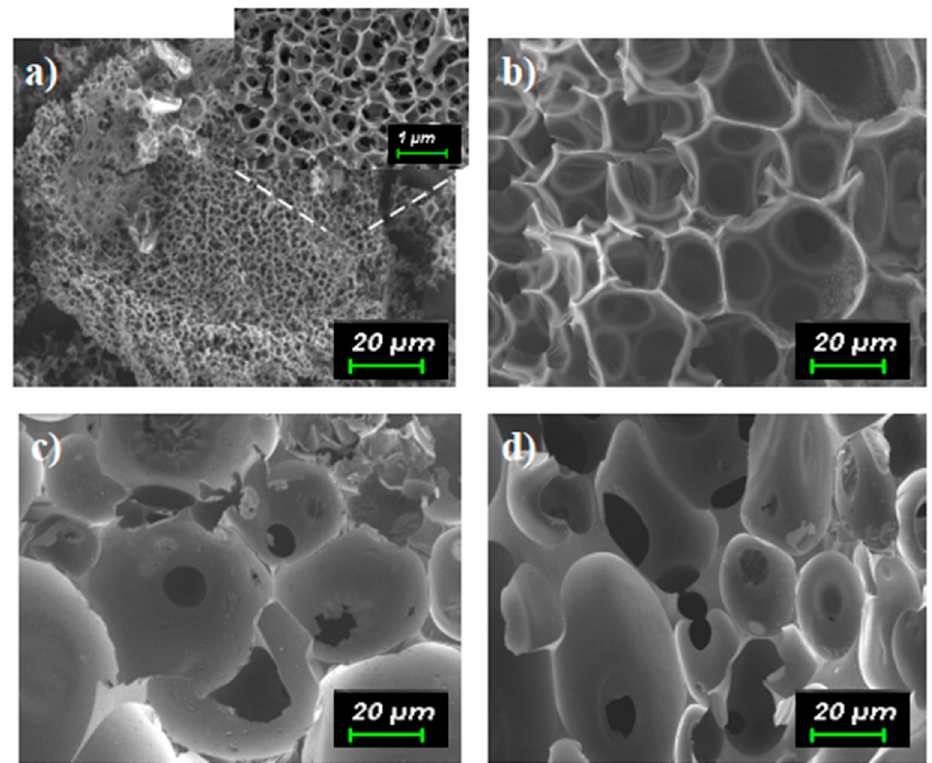
Figure 3. SEM images of ACs with four different activating agents: ( a ) KAAC; ( b ) ZAAC; ( c ) SAAC; ( d ) PAAC.